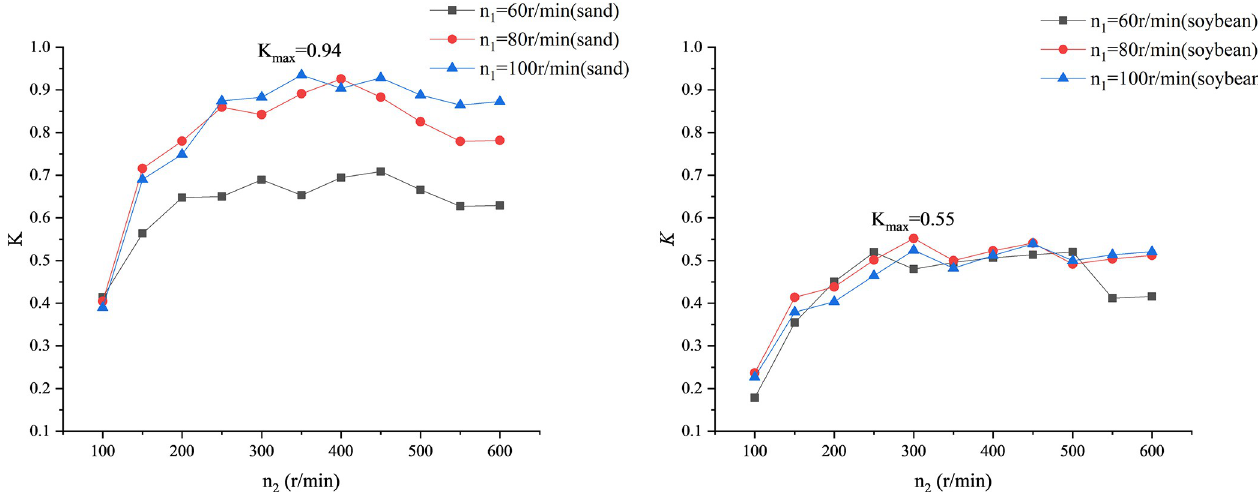
Fig 5. Curve of K versus screw speed n 2 . (A) Material: sand. (B) Material: soybean.